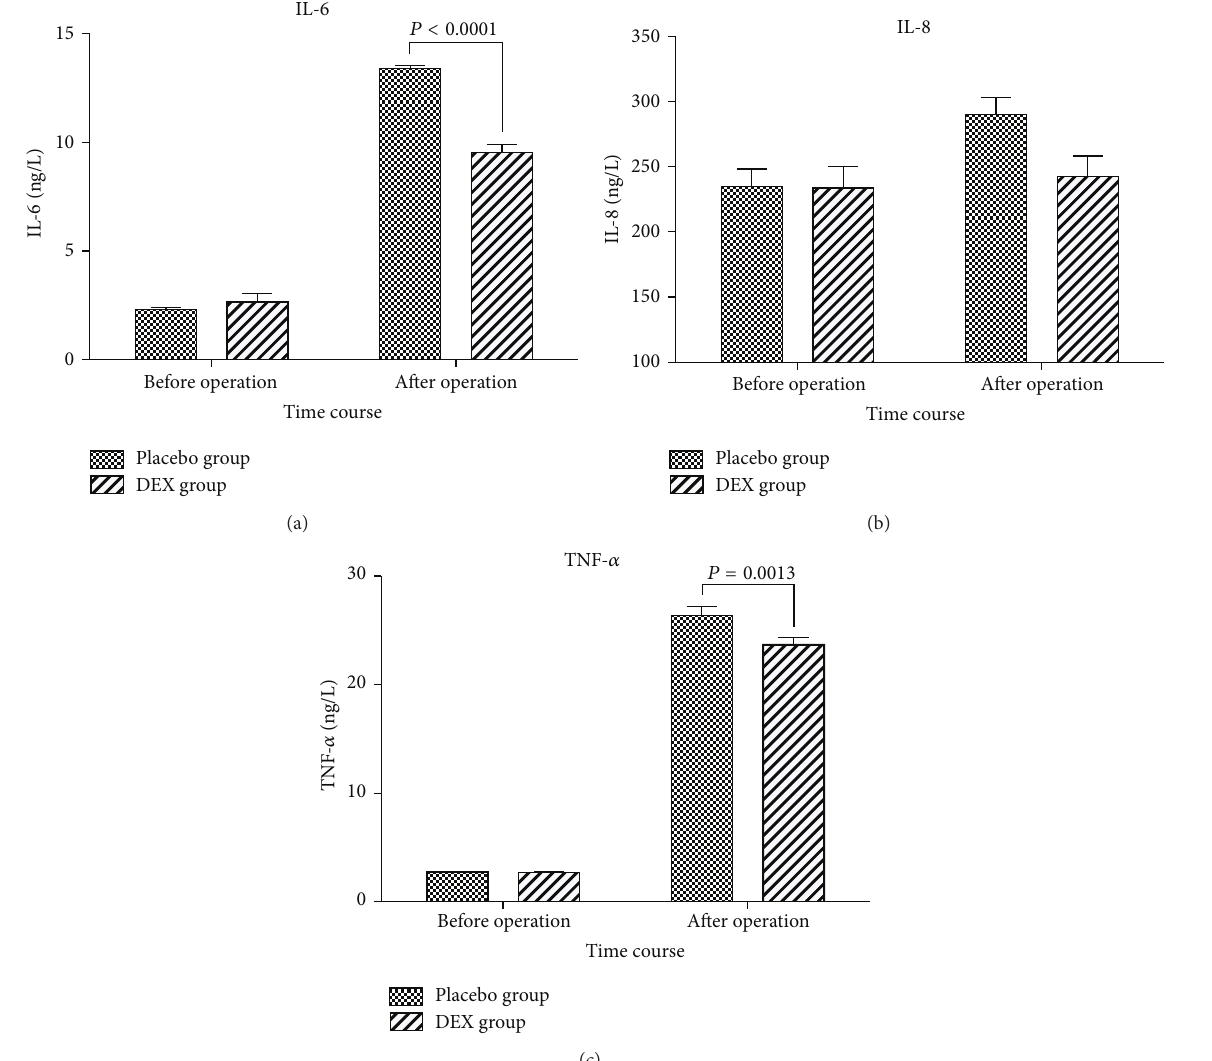
Figure 3: Plasma IL-6, IL-8, and TNF- 𝛼 concentration of patients receiving intranasal DEX and placebo before operation and after operation. Values are given as Mean ± SEM. IL-6 and TNF- 𝛼 were significant lower in DEX group after operation ( 𝑃 < 0.0001 and 𝑃 = 0.0013 , resp.).